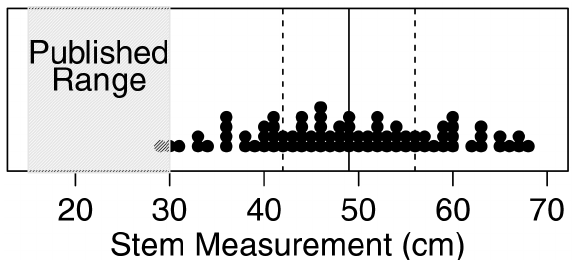
Figure 2. A plot of each exclosure individual in relation to the published stem range of 15–30 cm. The median of the dataset (49 cm) is marked with a solid line and the interquartile range (42–56 cm) lies between the dotted